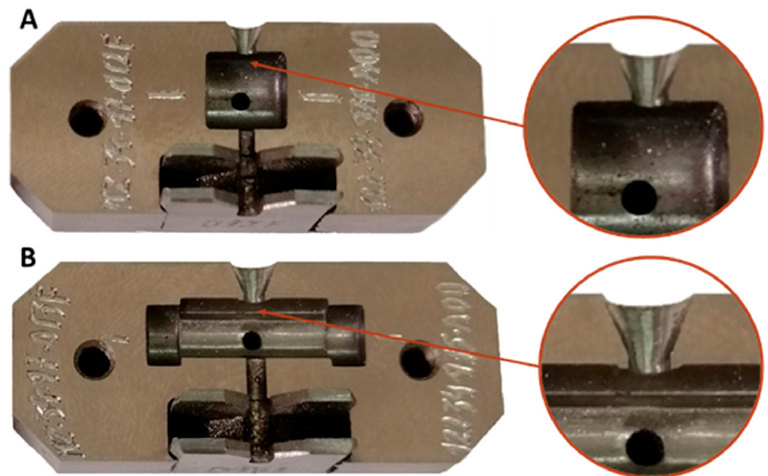
Figure 17. Original gating system for terminal of model 75 ( A ) and model 70 ( B ).